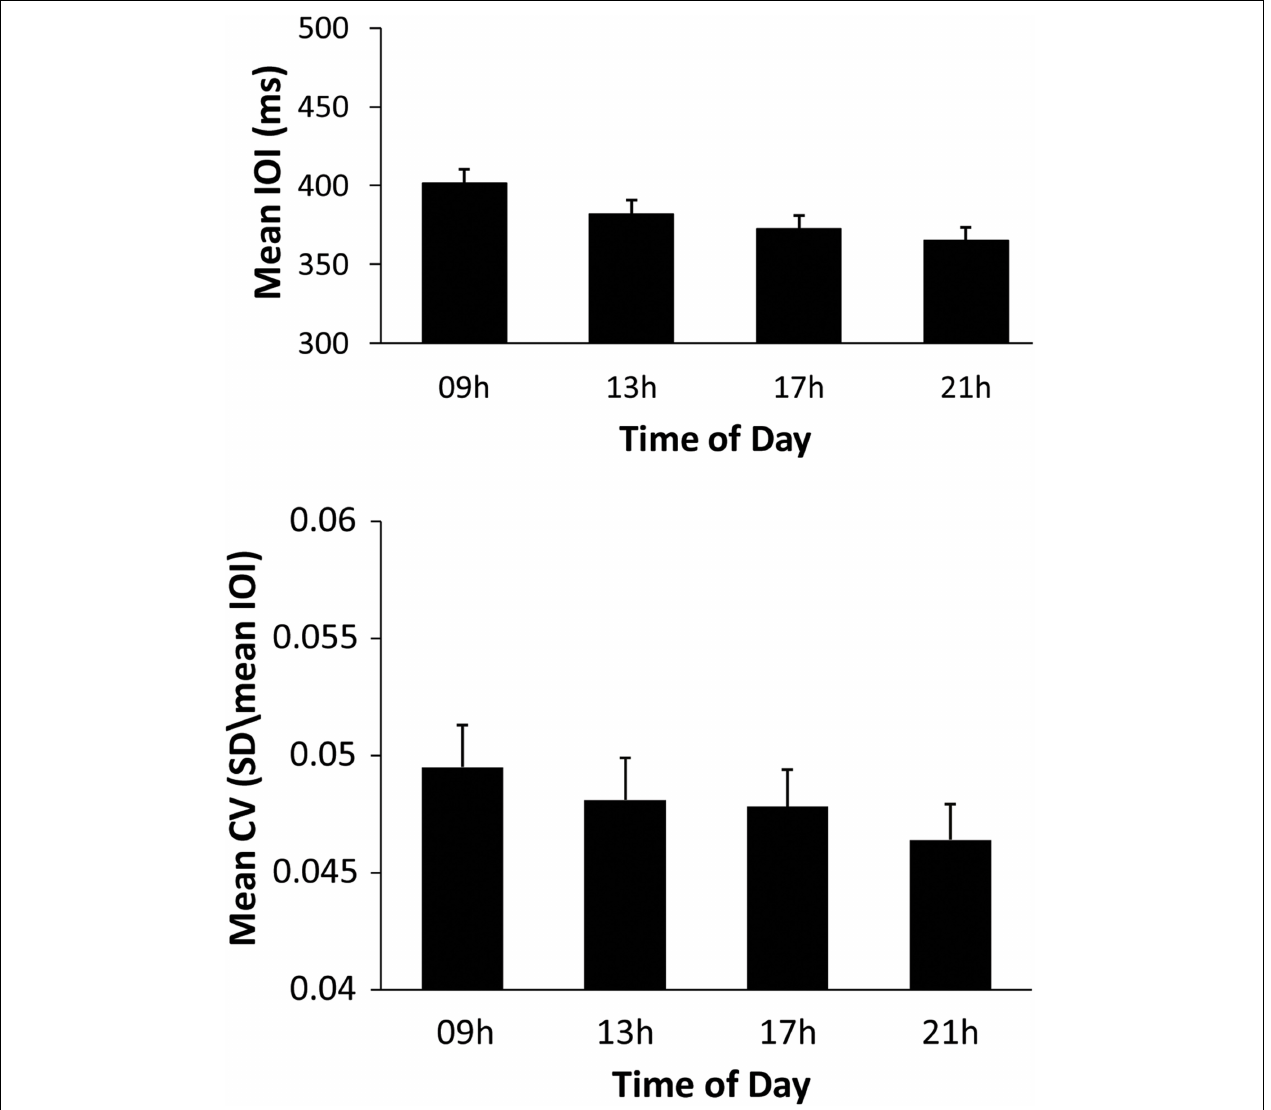
FIGURE 1 | Performers’ mean Spontaneous production rates (ms) by Time of Day (top) and mean CV by Time of Day (bottom) for all melody